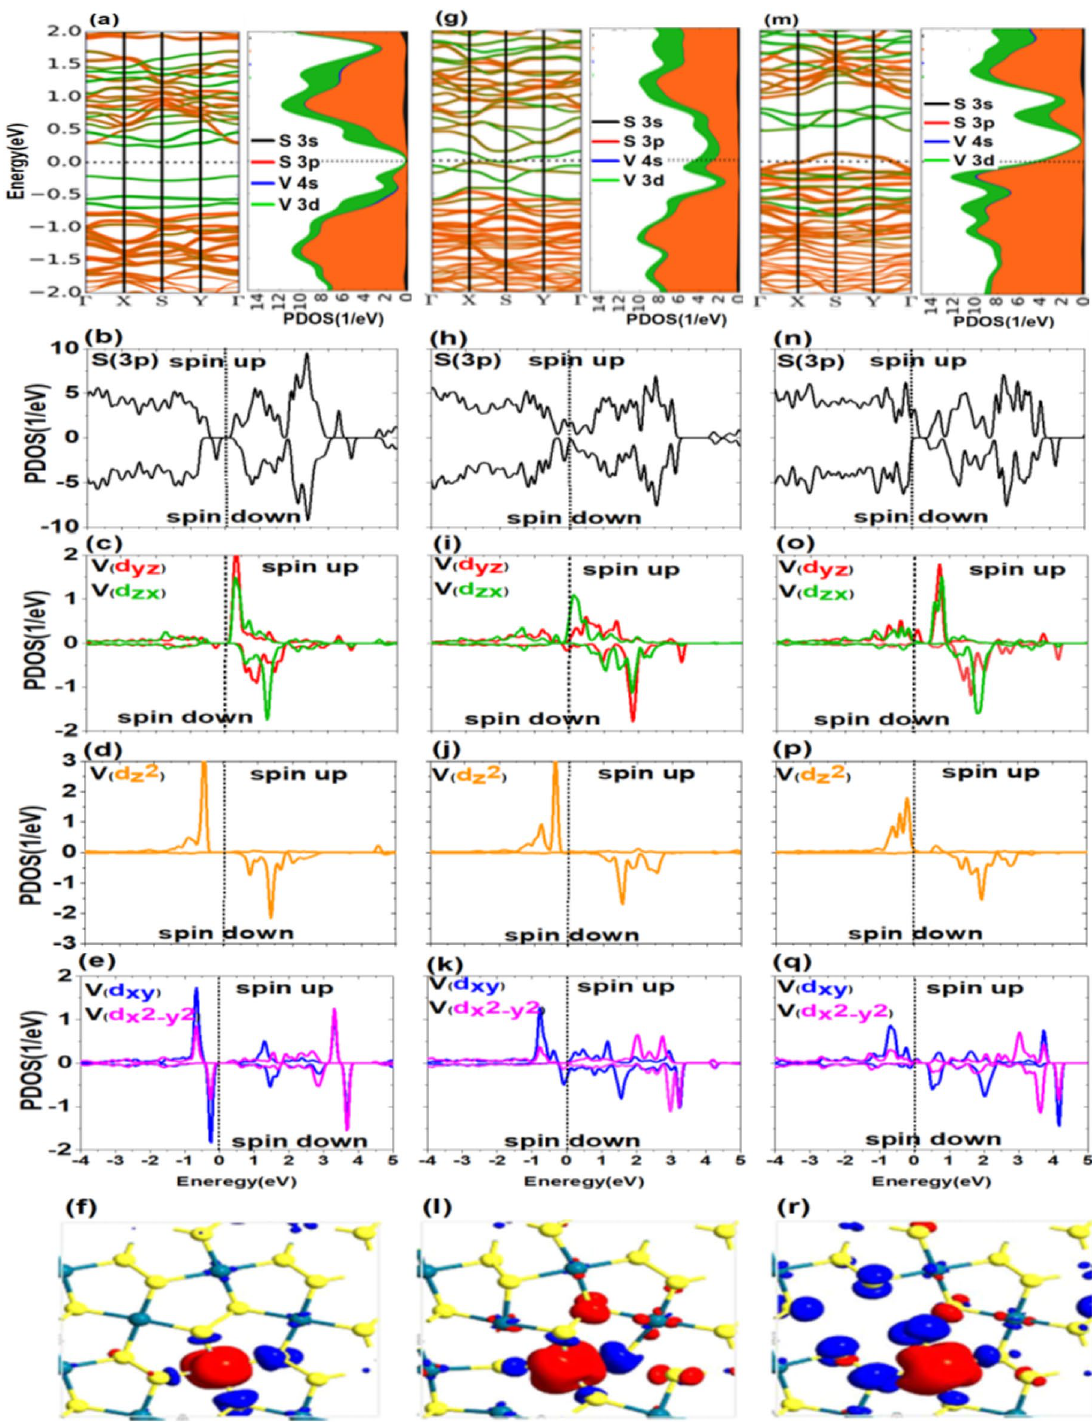
Figure 4. ( a–f ) Band structure and PDOS of p and d orbitals and spin density difference in the presence of transition metal impurity (V), ( g–i ) in the presence of the S atom defect, and ( m–r ) in the presence of the Pd atom